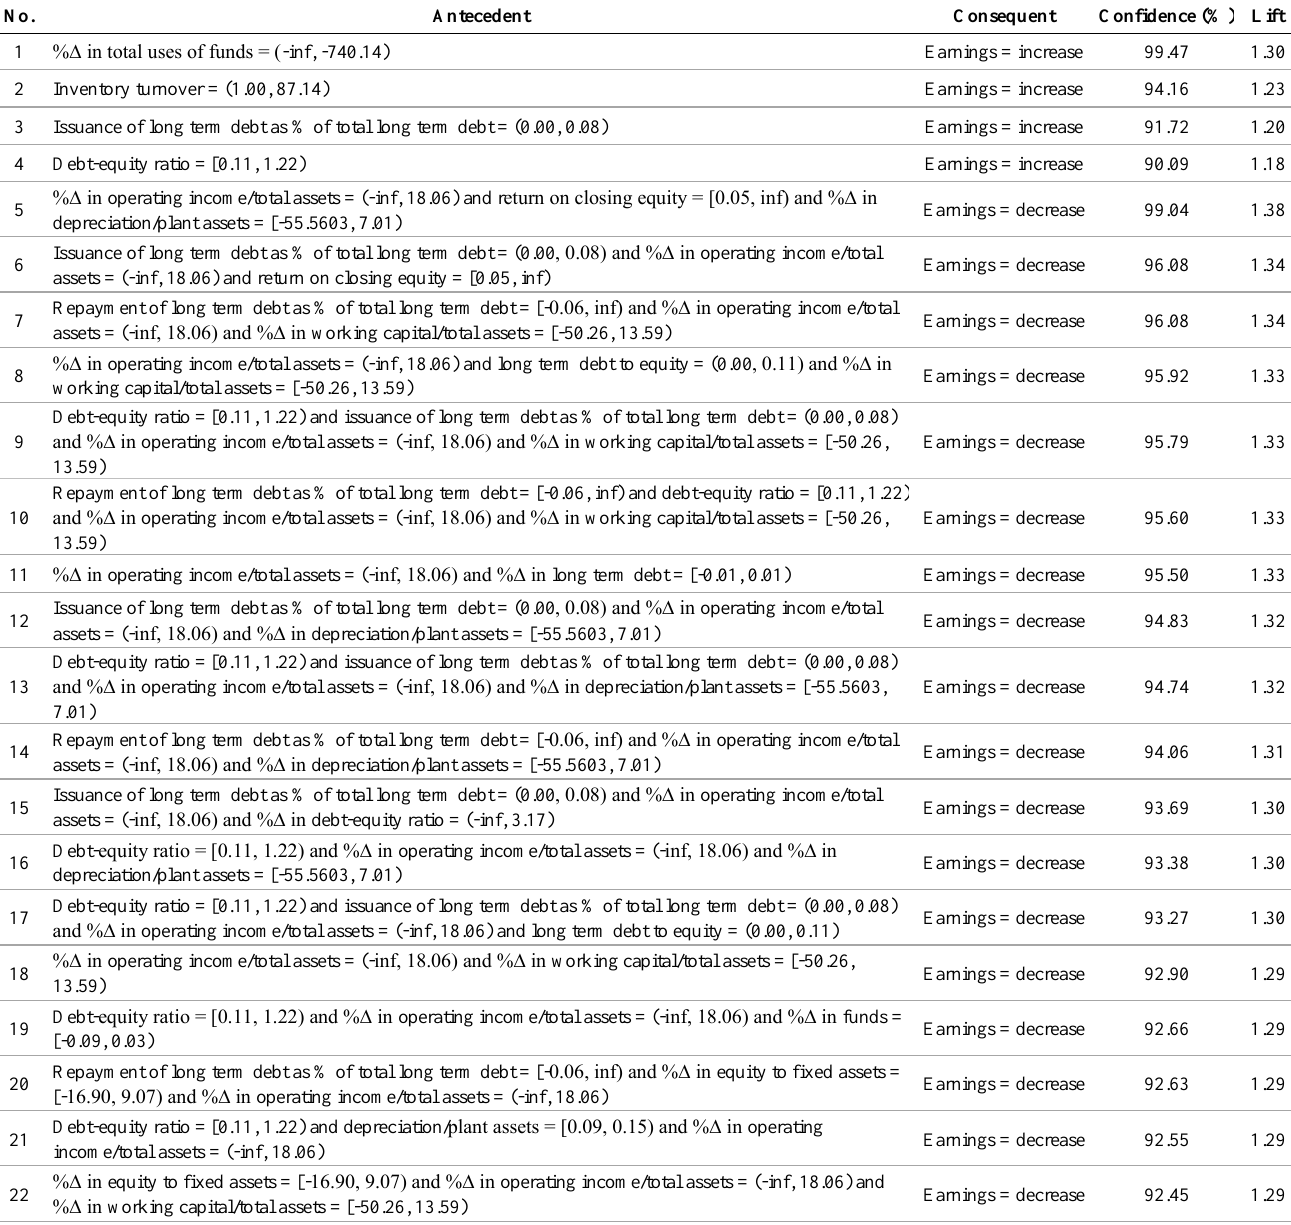
Table 7. Earnings associated patterns derived from